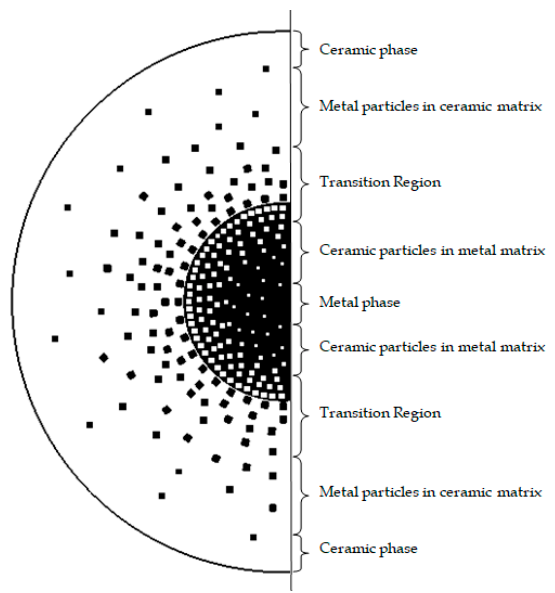
Figure 1. Material gradation of metal and ceramic phases along the radial direction of the shaft shown in the cross-sectional area of the shaft.